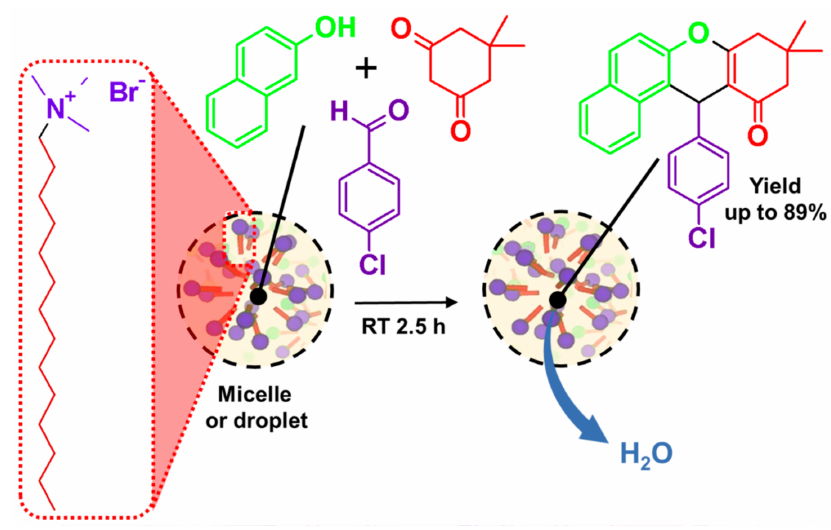
Figure 24. Synthesis of 12-(4-chlorophenyl)-9,9-dimethyl-8,9,10,12-tetrahydrobenzo[a] xanthen-11-one catalyzed by a tetradecyltrimethylammonium bromide surfactant at room temperature.